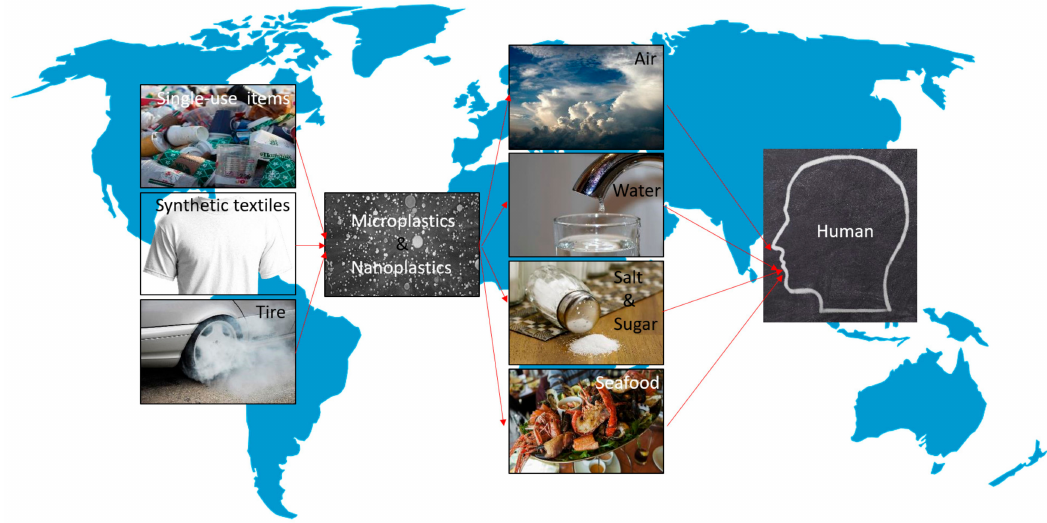
Figure 1. Some sources and deposits of microplastic and nanoplastic are the result of human needs. The potential impacts of these plastics on air, water, and many foods finally returns to a ff ect humans. All pictures come from Pixabay (https: // pixabay.com /